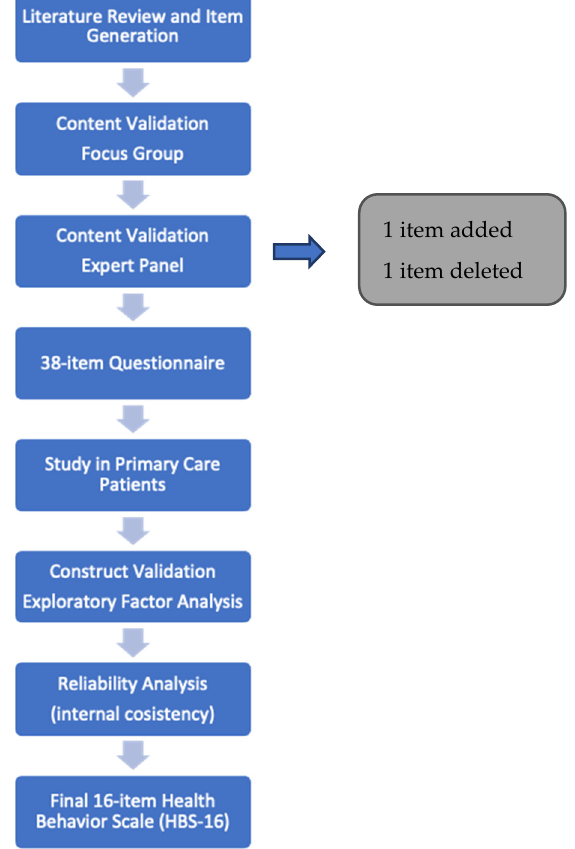
Figure 1. Health Behaviour Scale development and testing.